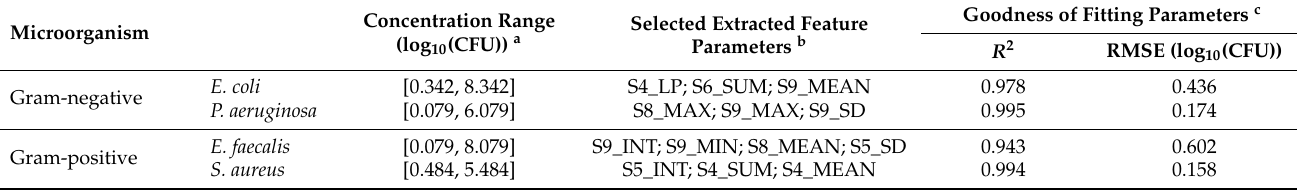
Table 3. Predictive performance (LOO-CV) of the MLRM developed based on selected feature extraction parameters derived from the interaction of the E-nose-MOS sensors with the VOCs emitted by each one of the four bacteria studied: E. coli , P. aeruginosa , E. faecalis , and S. aureus (number of each bacterium, i.e., contents in log 10 (CFU)).